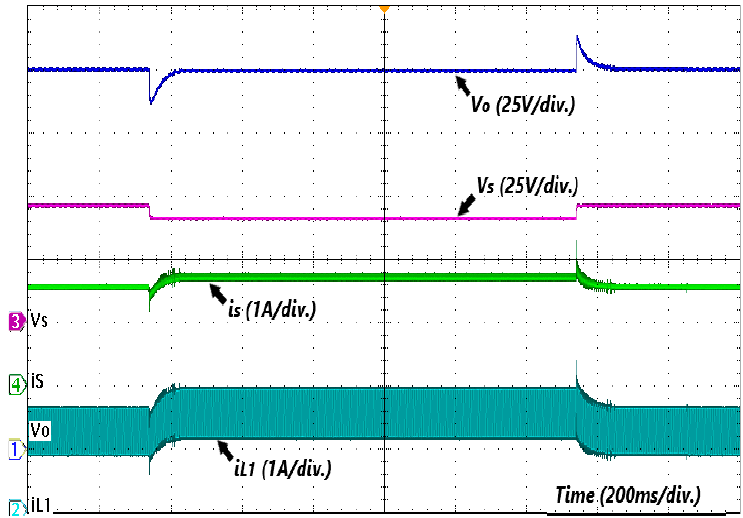
Figure 16. Transient response under input voltage change.